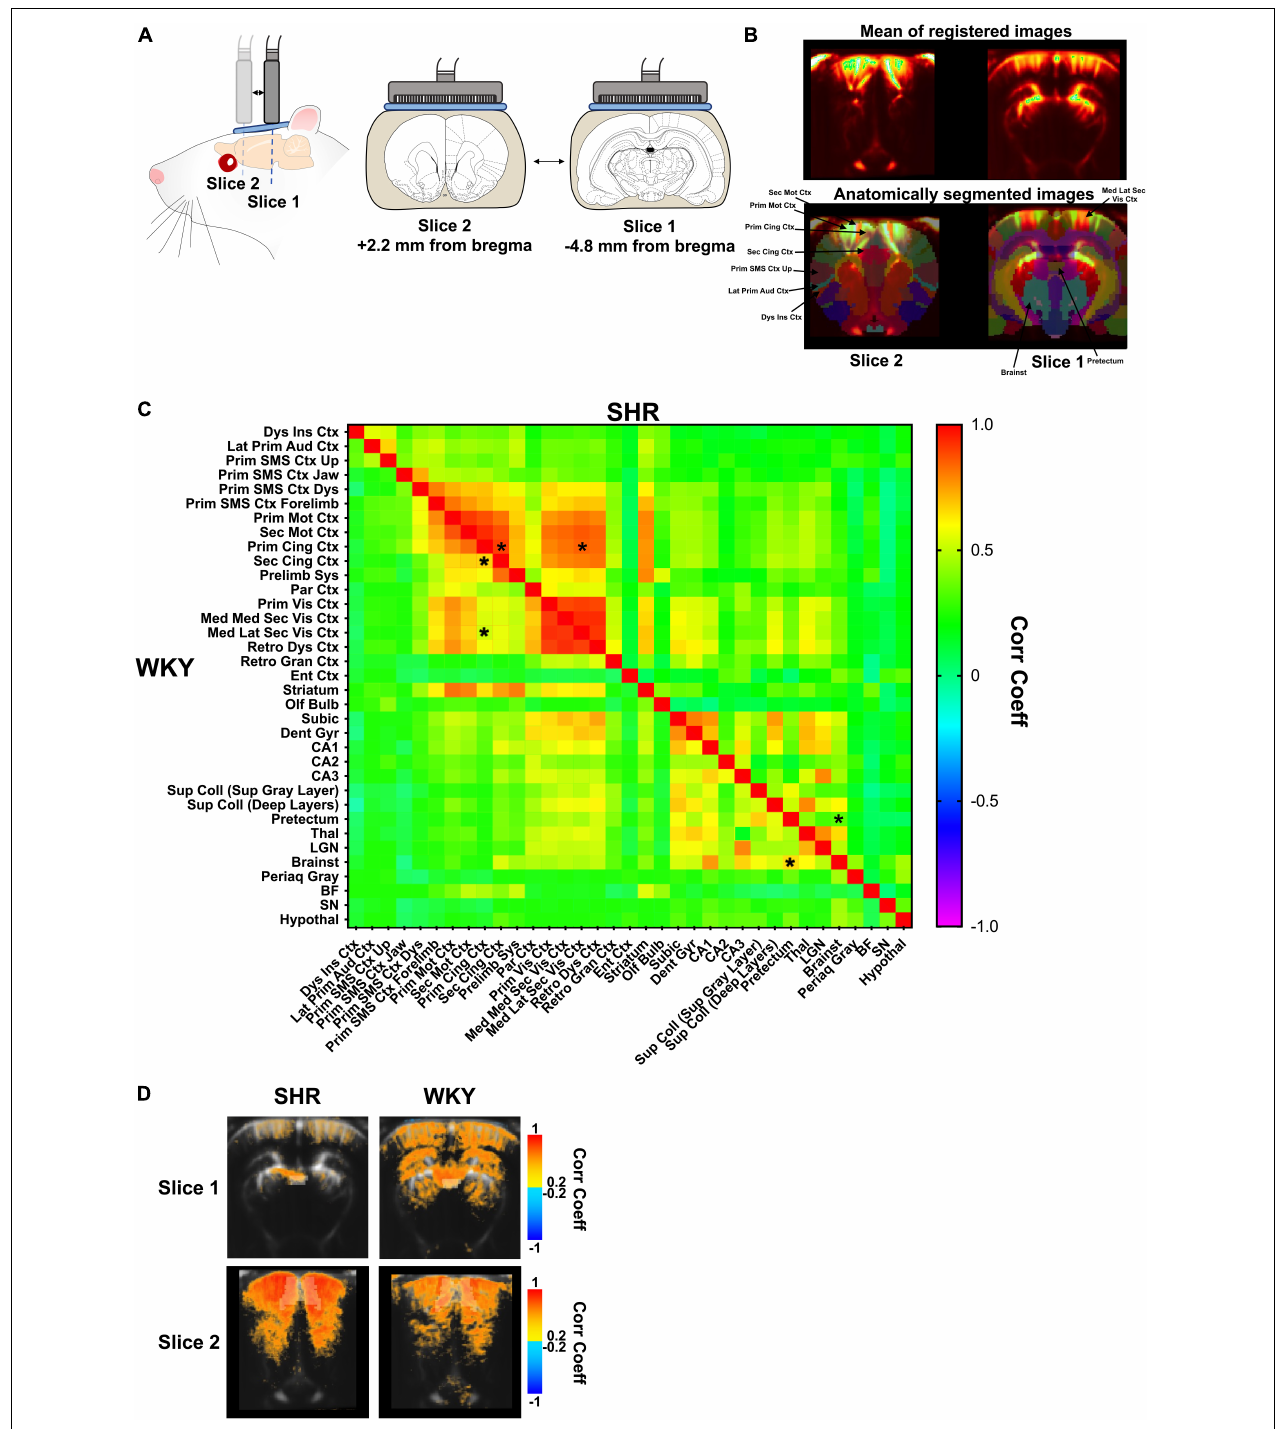
FIGURE 2 | Resting-state long-range functional connectivity in SHR and WKY rats. Functional ultrasound acquisition in the absence of stimulation (i.e., resting-state condition) (A) ; During resting-state experimentation, the probe alternates between bregma –4.8 mm and bregma +2.2 mm. (B) Mean of registered images during a fUS session (upper) and overlay of an anatomical atlas (lower) for all animals. Some regions of interest are shown for a better understanding of the main results. (C) Two-way ANOVA followed by multiple comparisons correction with a FDR of 0.1 (*). (D) Seed-based functional connectivity maps of slice 1 (top) and slice 2 (bottom) in SHR (left) and WKY (right) rats showing the connectivity with the pretectum (top) or primary cingulate cortex (bottom) with the other pixels on the same slice (average of all animals for each group).